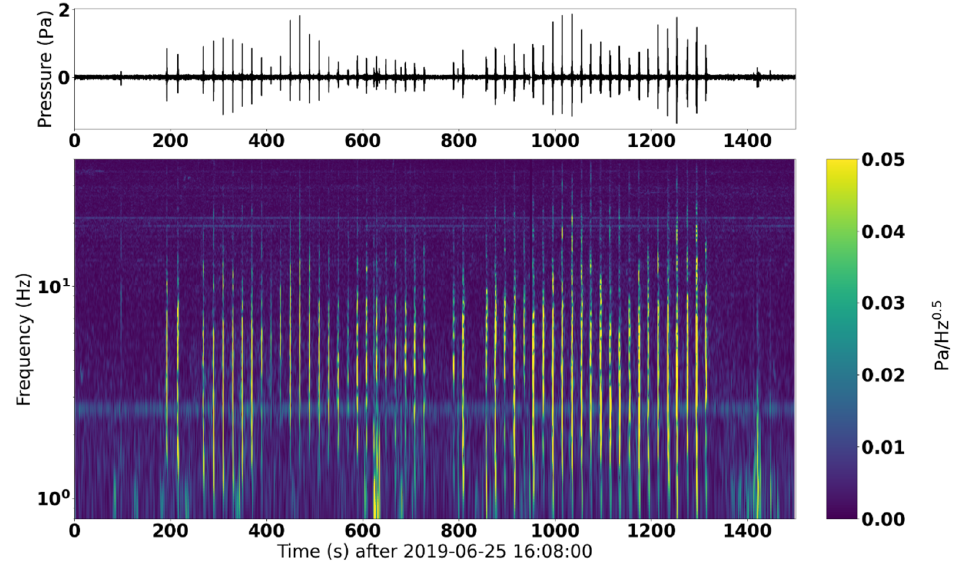
Figure 11. ( top ) Time trace and ( bottom ) spectrogram of OSU1-N on 25 June 2019 during the period when acoustic arrivals from MCAAP munition detonations were confirmed. Time is measured in seconds relative to 16:08 UTC.